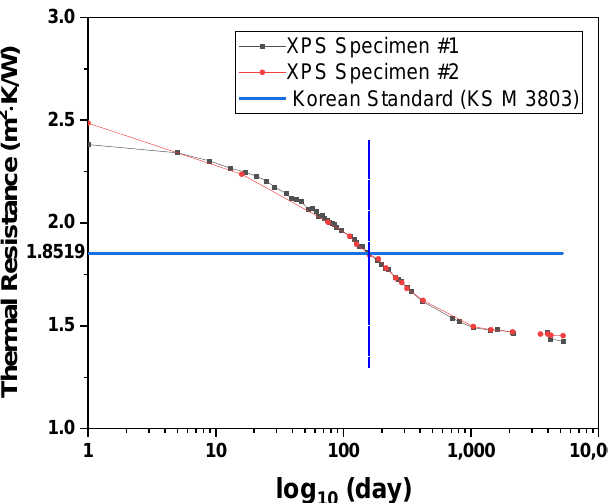
Figure 4. Thermal resistance of two XPS specimens. Redrawn based on previous results [15,16].